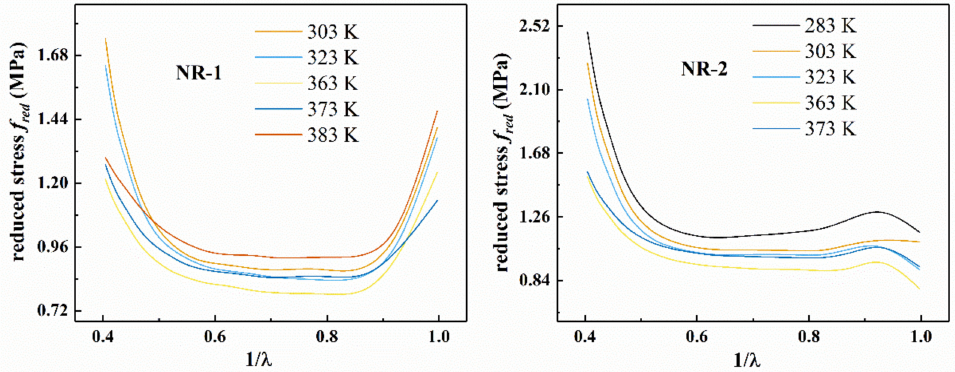
Figure 3. Mooney plots of NR-1 and NR-2 under uniaxial tension at different temperatures.